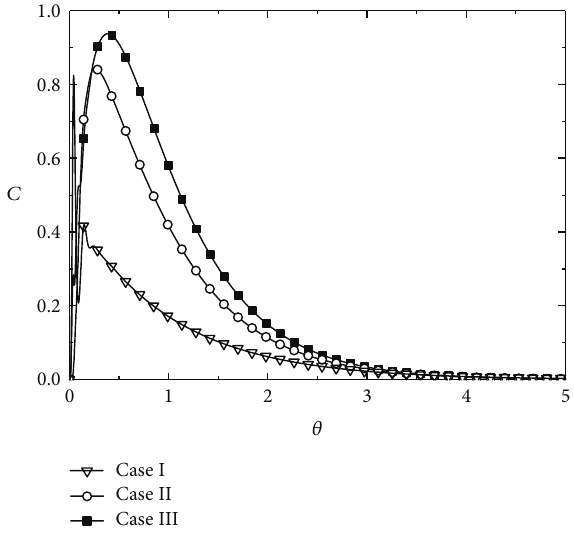
Figure 6: RTD curves for the three cases studied.